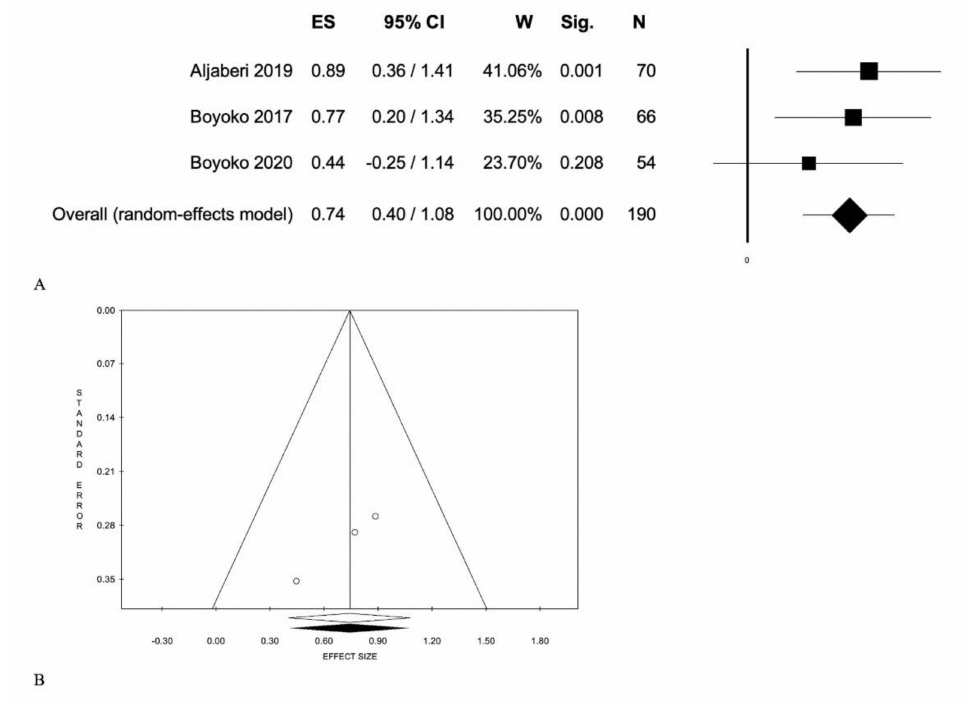
Figure 3. Active systemic disease vs. any inactive disease form (systemic and articular): ( A ) Forest plot; ( B ) Funnel